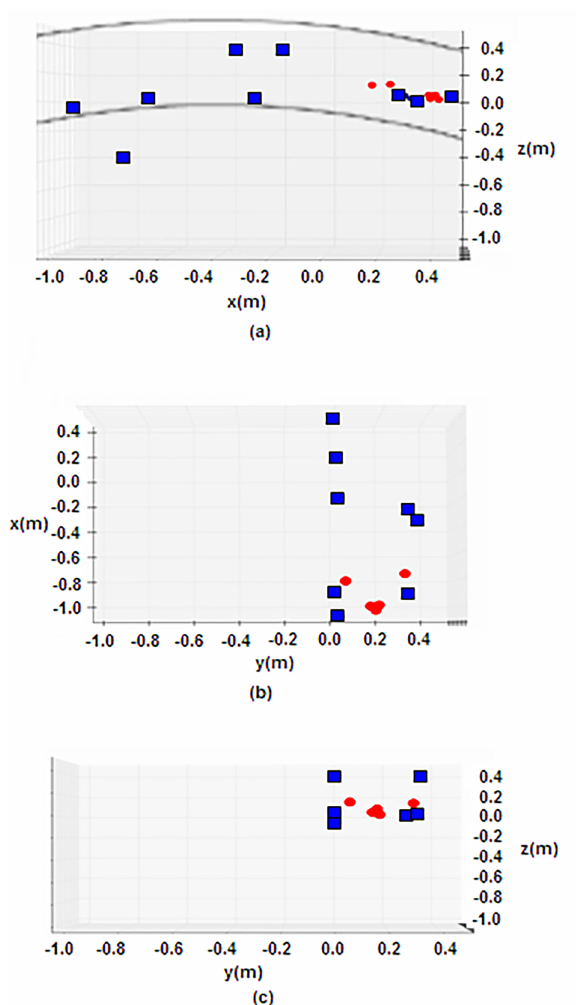
Figure 3. 3-D map showing the positions of transducers (blue squares) and localized AE sources (red dots): front (a) , upper (b) and side view (c)